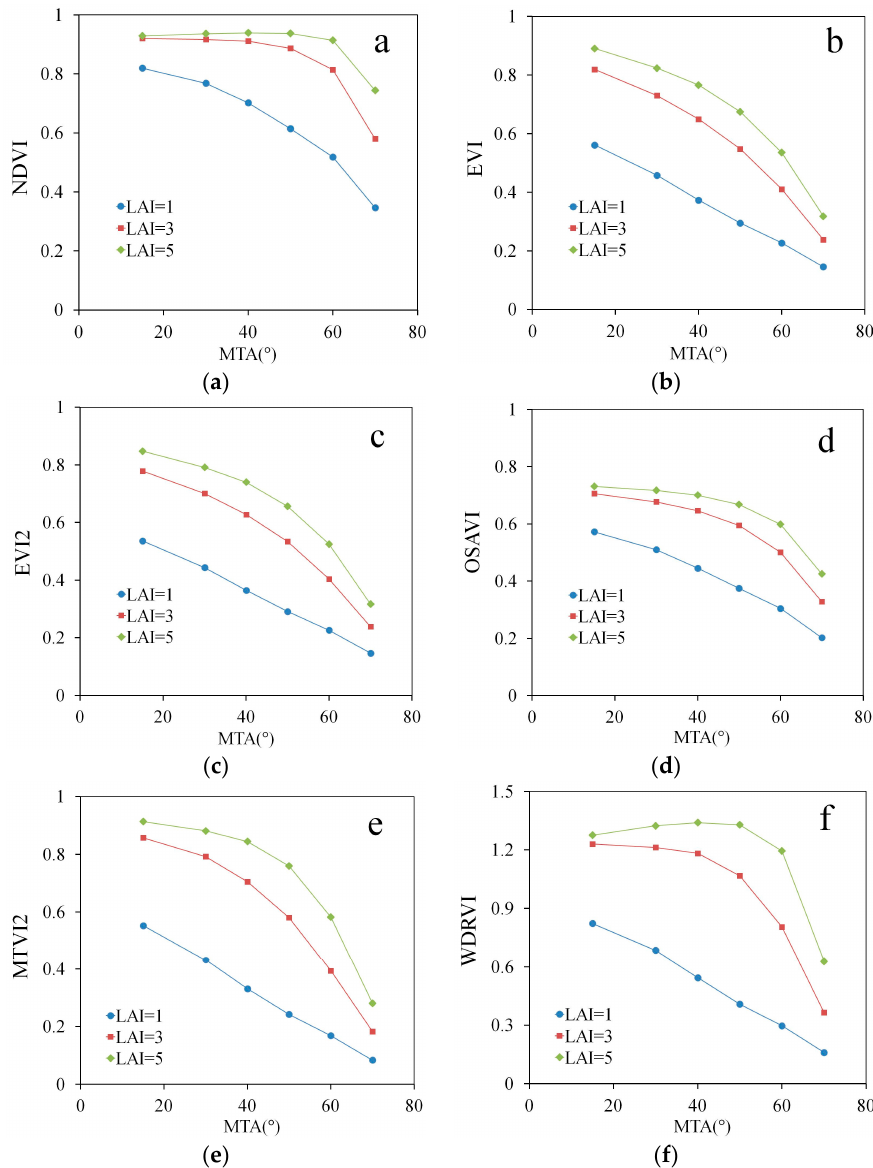
Figure 2. Relationship between MTA and VIs at different LAI values (low: LAI = 1, medium: LAI = 3 and high: LAI = 5) for ( a ) NDVI, ( b ) EVI, ( c ) EVI2, ( d ) OSAVI, ( e ) MTVI2, ( f ) WDRVI.